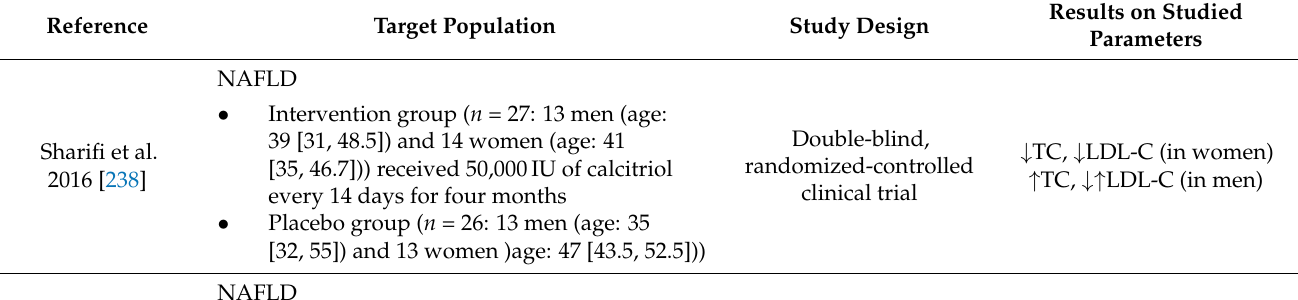
Table 2. The outcome of the interventional clinical trials focused on the effect of vitamin D supple- mentation on the metabolic parameters related to lipid metabolism. ↑ —increase, ↓ —decrease and ↓↑ —no statistical effect. Results on Study Design